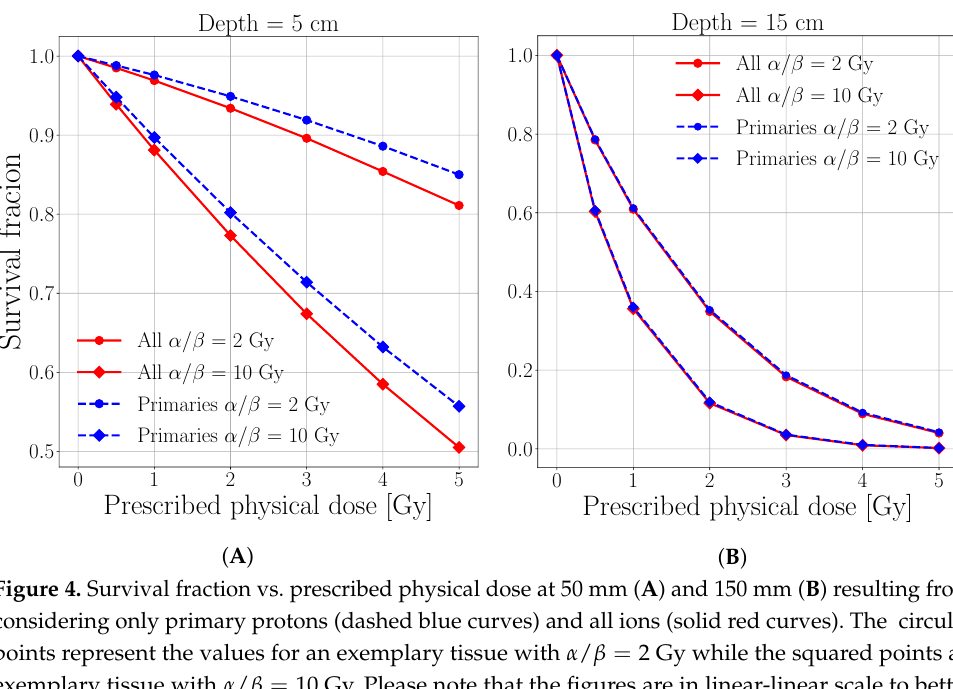
Figure 4. Survival fraction vs. prescribed physical dose at 50 mm ( A ) and 150 mm ( B ) resulting from considering only primary protons (dashed blue curves) and all ions (solid red curves). The circular points represent the values for an exemplary tissue with α / β = 2 Gy while the squared points an exemplary tissue with α / β = 10 Gy. Please note that the figures are in linear-linear scale to better appreciate the differences between the reported quantities in the high survival